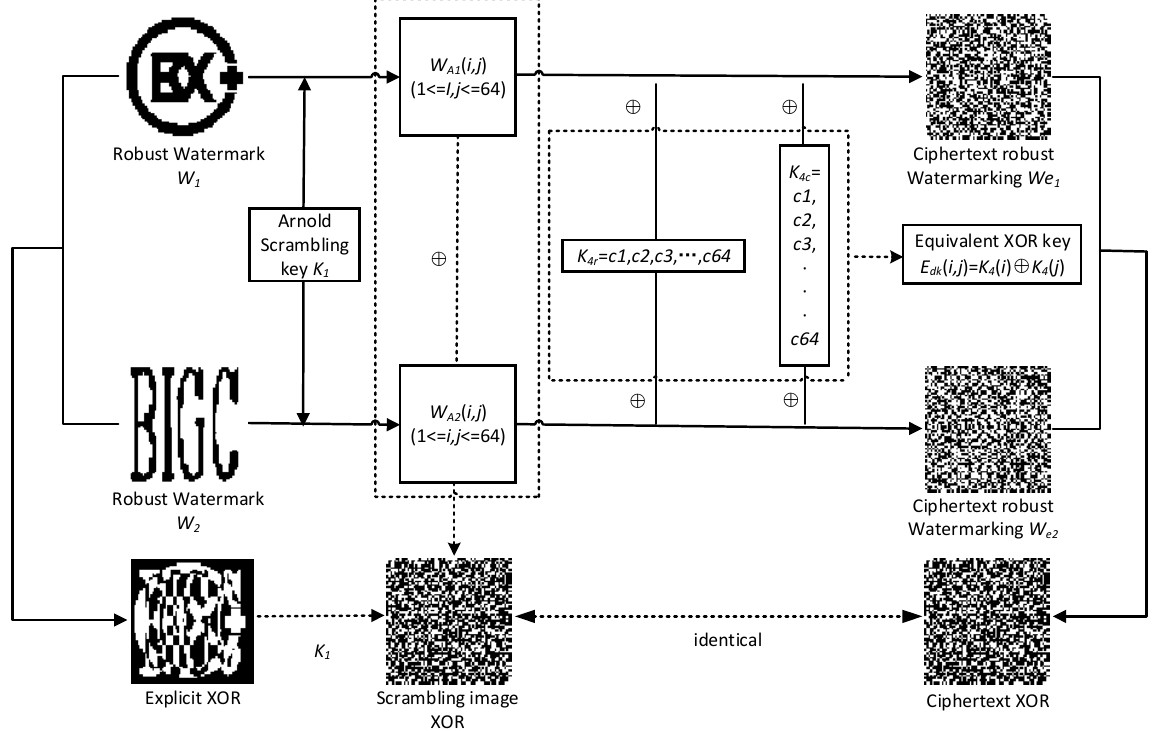
Figure 9. Watermark double encryption process cipher analysis.